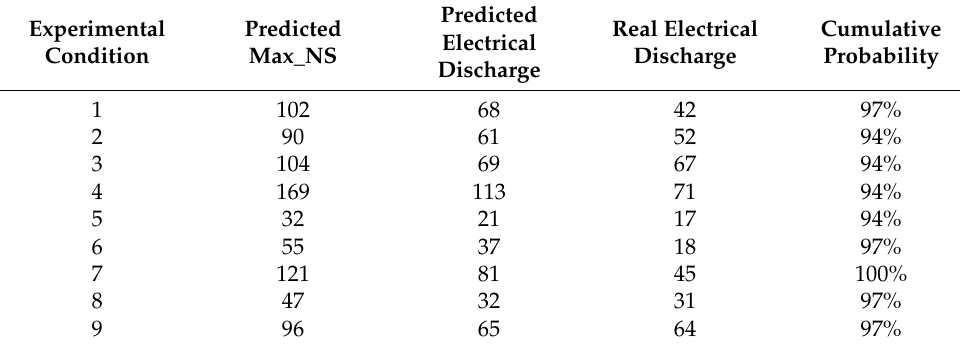
Table 4. Predicted Electrical discharge versus real electrical discharge.